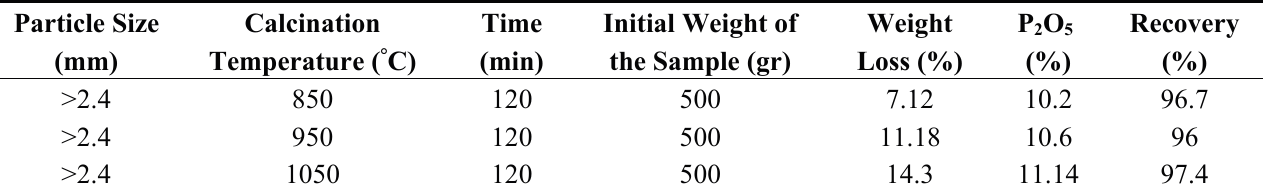
Table 5. Results of calcination test fractional class of >2.4